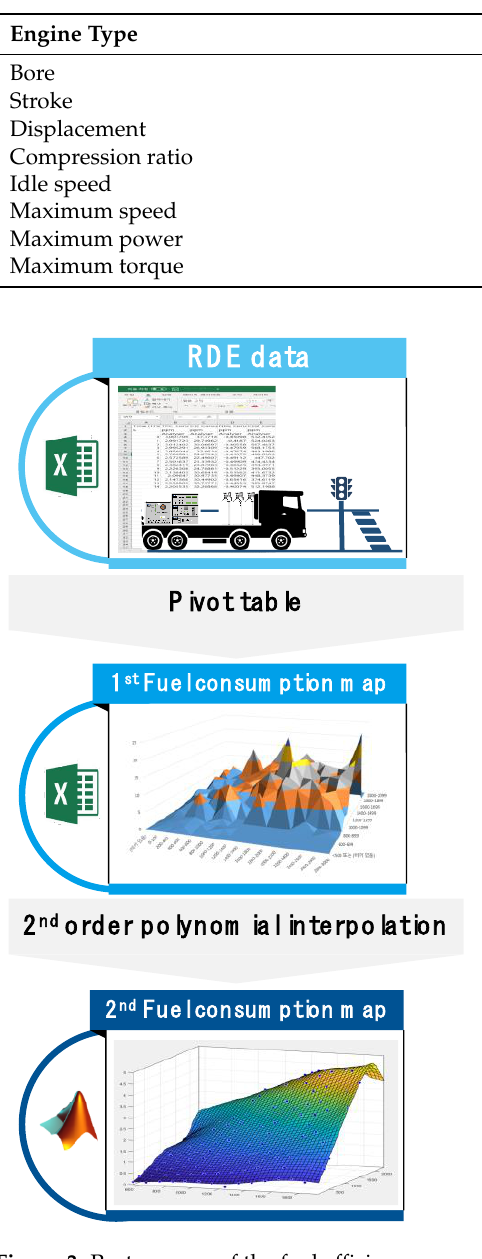
Figure 3. Post process of the fuel efficiency map.